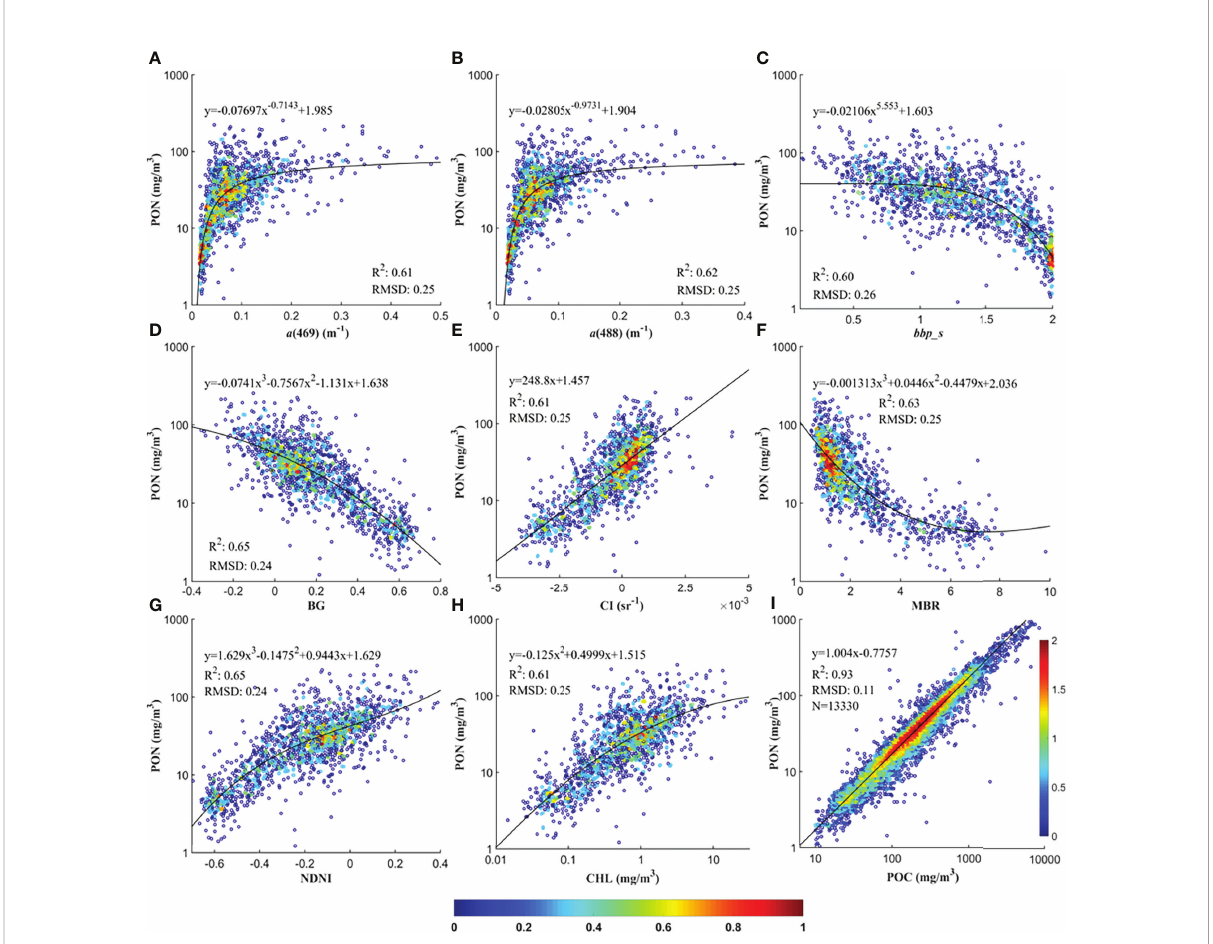
FIGURE 4 Oceanic PON concentrations retrieval models based on a (469) (A) , a(488) (B) , bbp_s (C) , BG (D) , CI (E) , MBR (F) , NDNI (G) , CHL (H) , and POC (I) , respectively. PON, CHL and POC are in log10 transformation. The numbers along the ramp indicate the pixel density after log10